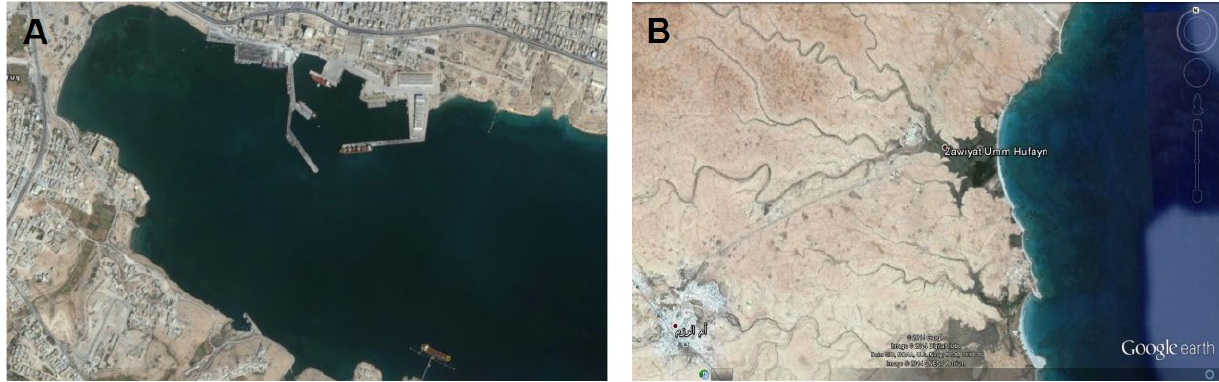
Figure 1. Sites from which the fish and water samples were collected: (A) Tubruk Harbor, Libya (32° 04' 30''N,23° 54' 48'' E) and (B) Umm Hufayan Lagoon, Libya (32° 33' 13'' N, 23° 05' 57'' E).